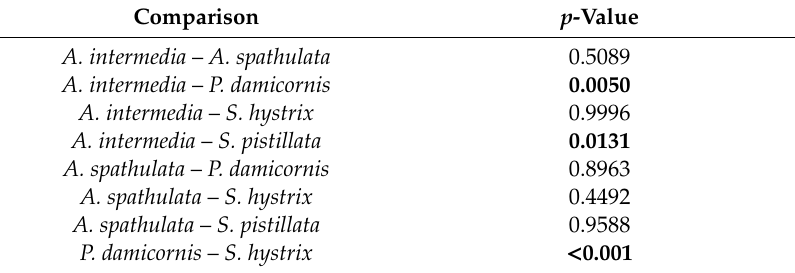
Table 2. Multiple comparisons of coral-species, with p -values, (Tukey’s honestly significant di ff erence (HSD) post hoc) based on a binomial generalized linear model of colony occupancy with damselfish species pooled (reef seascape dataset): colony occupancy (dependent) and colony species (independent variable). Significant p -values are in